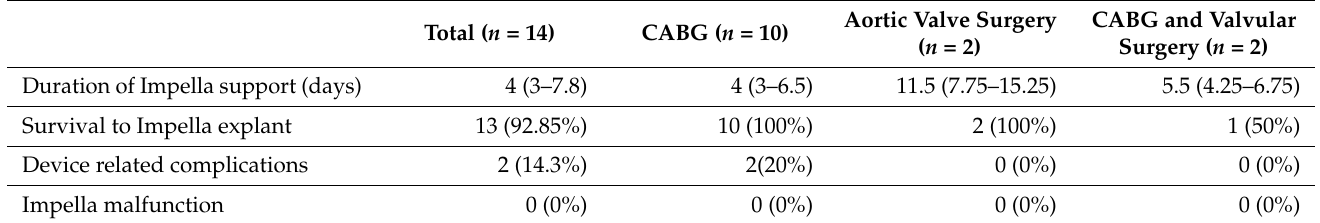
Table 2. Impella related data.